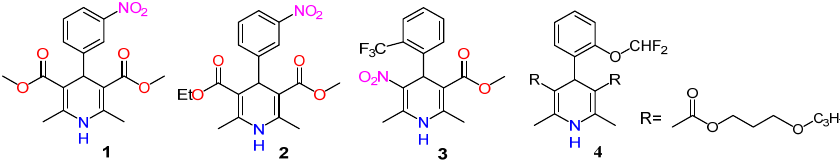
Figure 1. The structural formulas of biologically active 1,4-DHP.